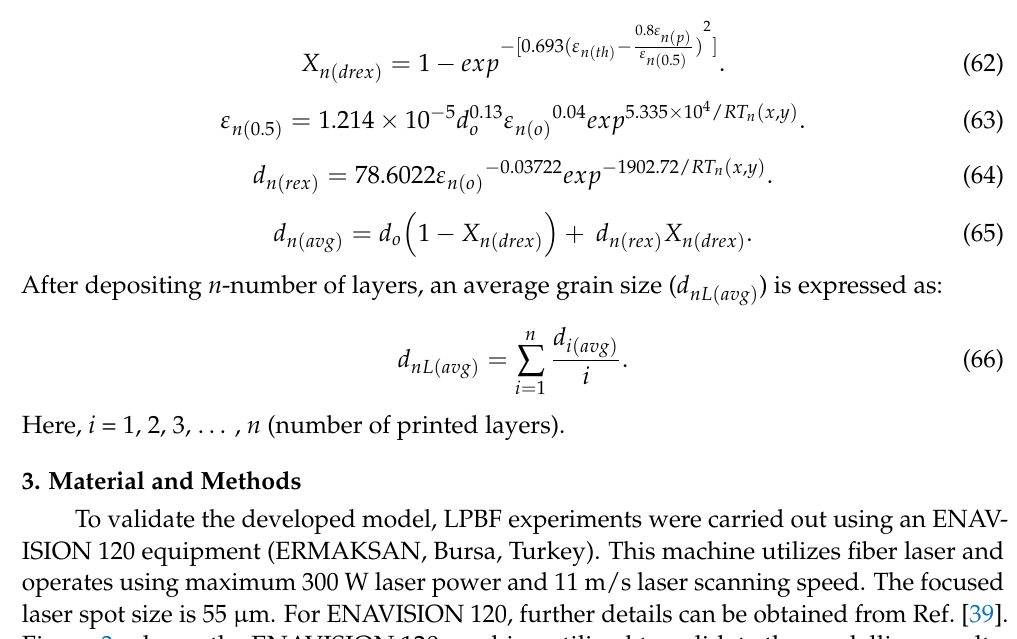
Table 1. Operating conditions to print 15 specimens via the LPBF process. Sample No.